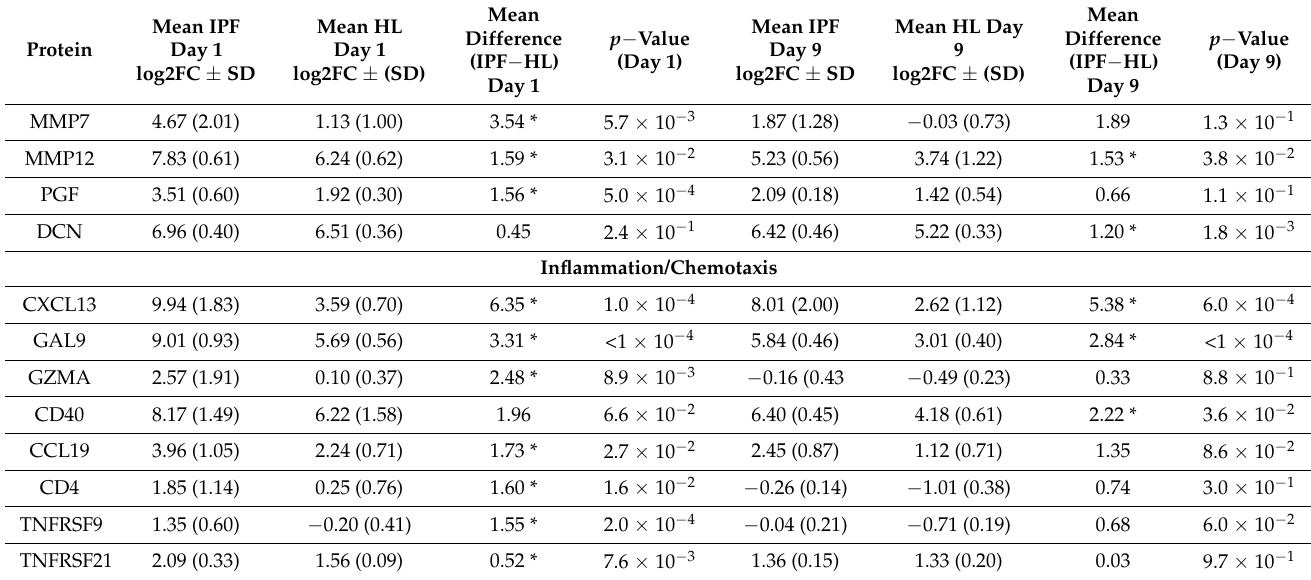
MMP7 and CXCL13, demonstrated the largest increase compared to repopulated healthy scaffolds. Table 1. Proteins significantly elevated in cell medium from repopulated IPF scaffolds. In comparison to healthy scaffolds (HL), fibroblasts cultured on IPF scaffolds demonstrated an increased release of 12 proteins. Table show proteins ranked based on difference in group mean (NPX values) between IPF and healthy condition, categorized into two main biological functions. Two-way ANOVA with Sidak’s multiple comparison test, * p < 0.05.